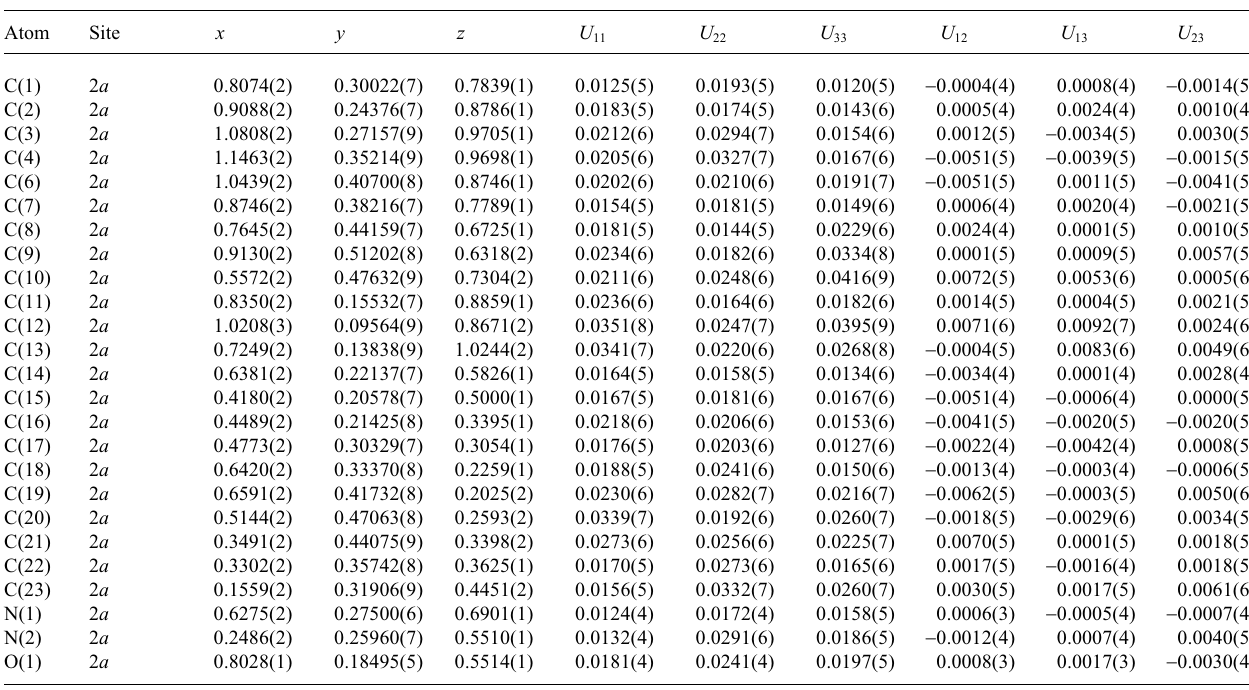
Table 3. Atomic coordinates and displacement parameters (in Å 2 )